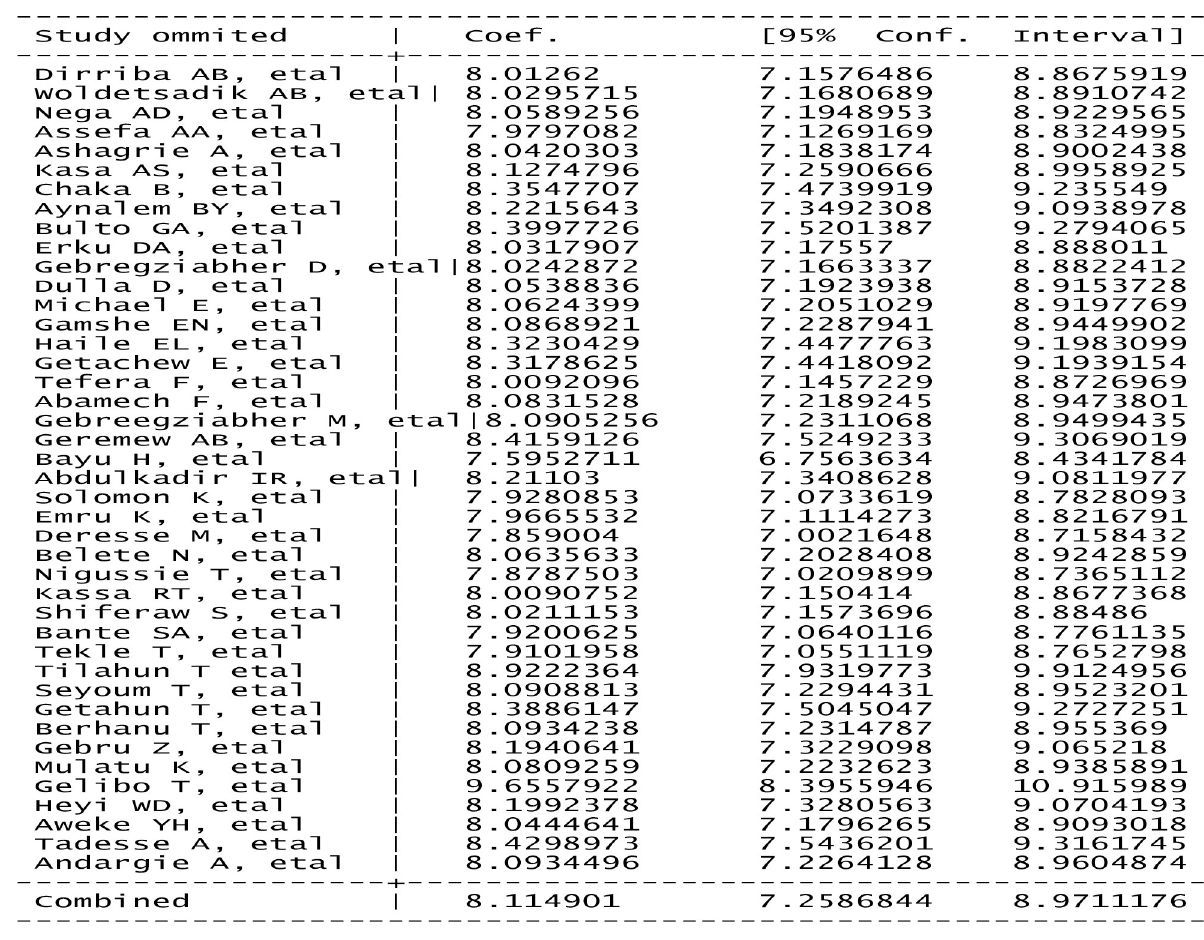
Fig 4. Results of the sensitivity analysis of the 42 studies in the